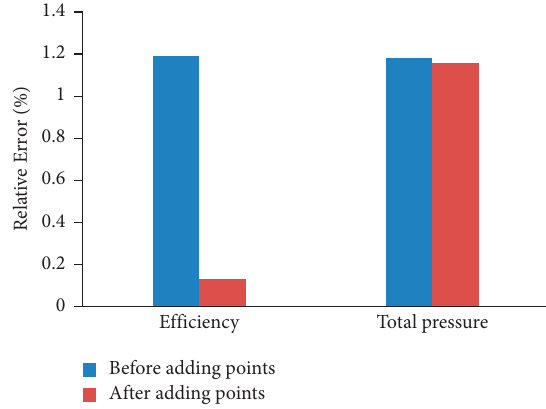
Figure 9: Relative ftting error before and after adding points.